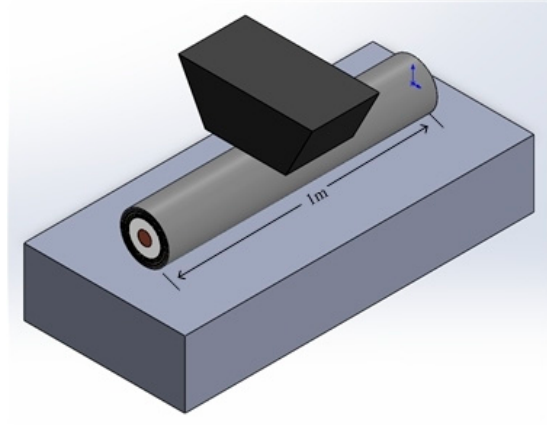
Figure 3. Anchor damage overall model diagram.